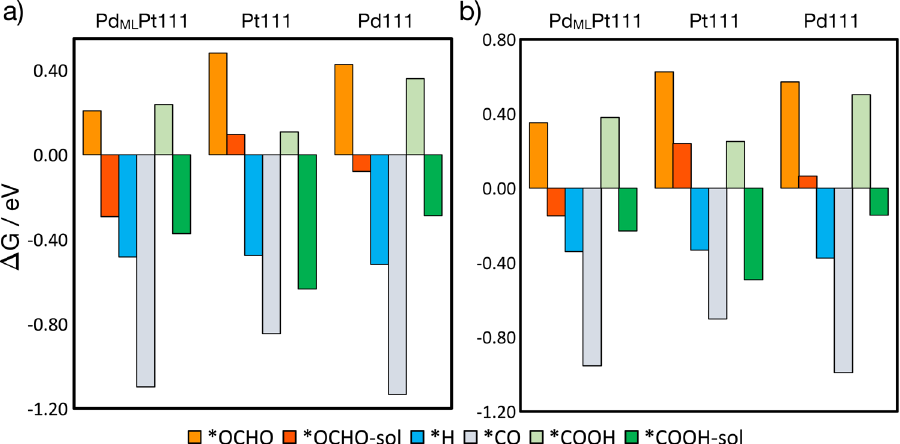
Fig. 4 Formation energies of various adsorbates. a Formation energies of adsorbed *OCHO, *H, *COOH, and *CO at 1/9 ML coverage at 0 V vs RHE on Pd ML Pt(111), Pt(111), and Pd(111) from formic acid in solution. b Formation energies of adsorbed *OCHO, *H, *COOH, and *CO at 1/9 ML coverage at 0 V vs. RHE on Pd ML Pt(111), Pt(111), and Pd(111) calculated relative to CO 2 (g), electrons, and protons, and for *H, calculated relative to (H + + e − ). *OCOH in bright orange is non-solvated and in dark orange/red it is solvated, *OCHO-sol. *COOH in light green is non-solvated and in dark green it is solvated,